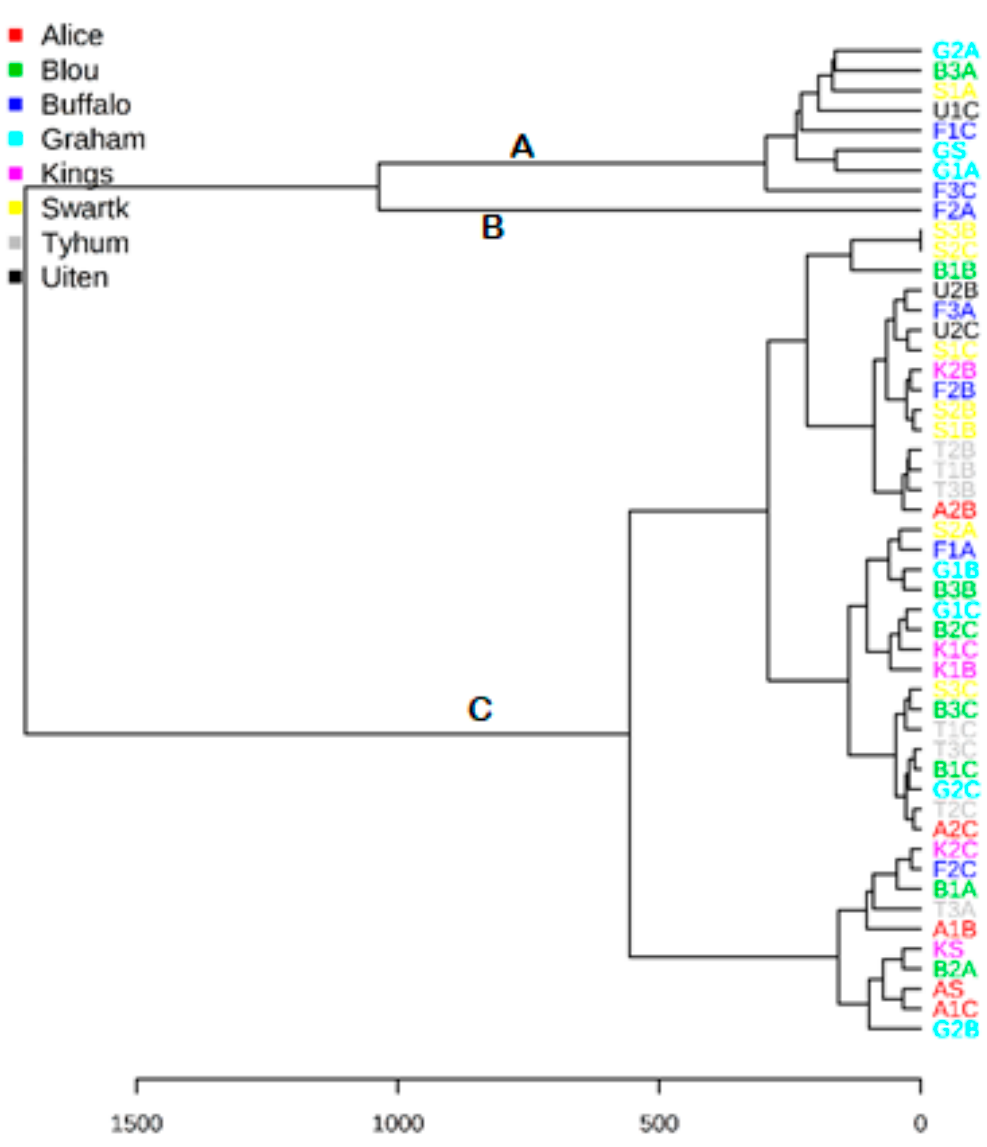
Figure 4. Clustering result shown as a dendrogram. The distance was measured with Euclidean and clustering algorithm with Ward D.